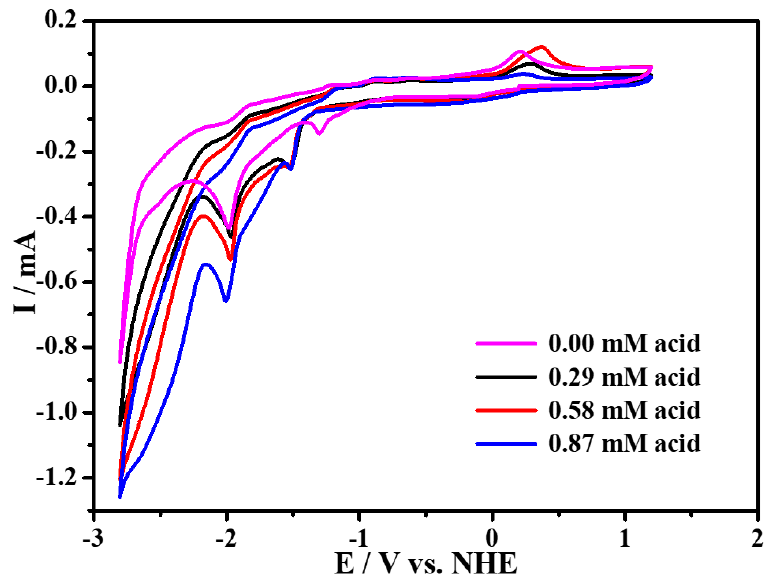
Figure 7. Cyclic voltammograms of complex 1 (2 mM) recorded in the absence (rose red trace) and in the presence of TsOH · H 2 O: 1 equiv (black trace), 2 equiv (red trace), and 3 equiv (blue trace) in